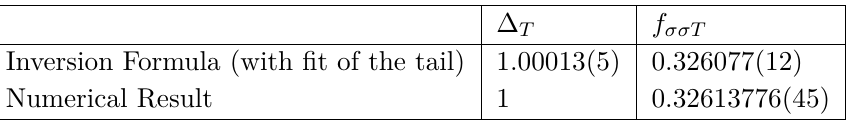
Table 1 . Twist and OPE of the stress-tensor, the spin 2 operator in [ σσ ] 0 , derived from the inversion integral (all the 3 families and the high spin tail from the fit is included) compared with the value derived from numerical